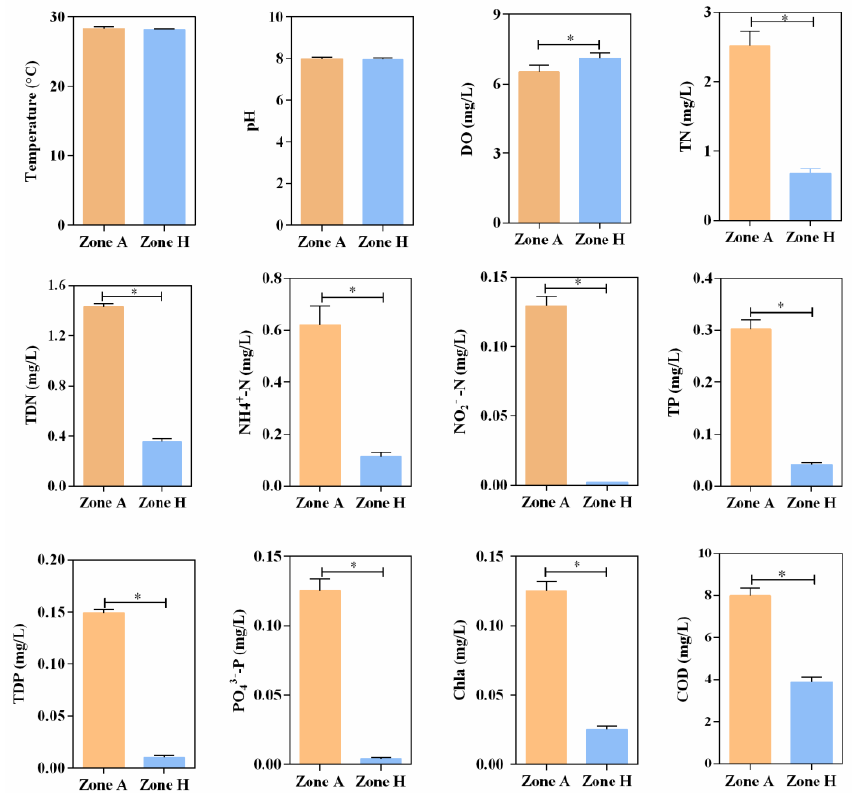
Figure 1. The physicochemical parameters of water. The difference between the two groups was compared using a t -test. “*” indicated p < 0.05. DO: dissolved oxygen; TN: total nitrogen; TDN: total dissolved nitrogen; NH 4+ -N: ammonium; NO 2 − -N: nitrite nitrogen; TP: total phosphorus; TDP: total dissolved phosphorus; PO 4 3 − -P: orthophosphate; Chla: chlorophyll A; COD: chemical oxygen demand.